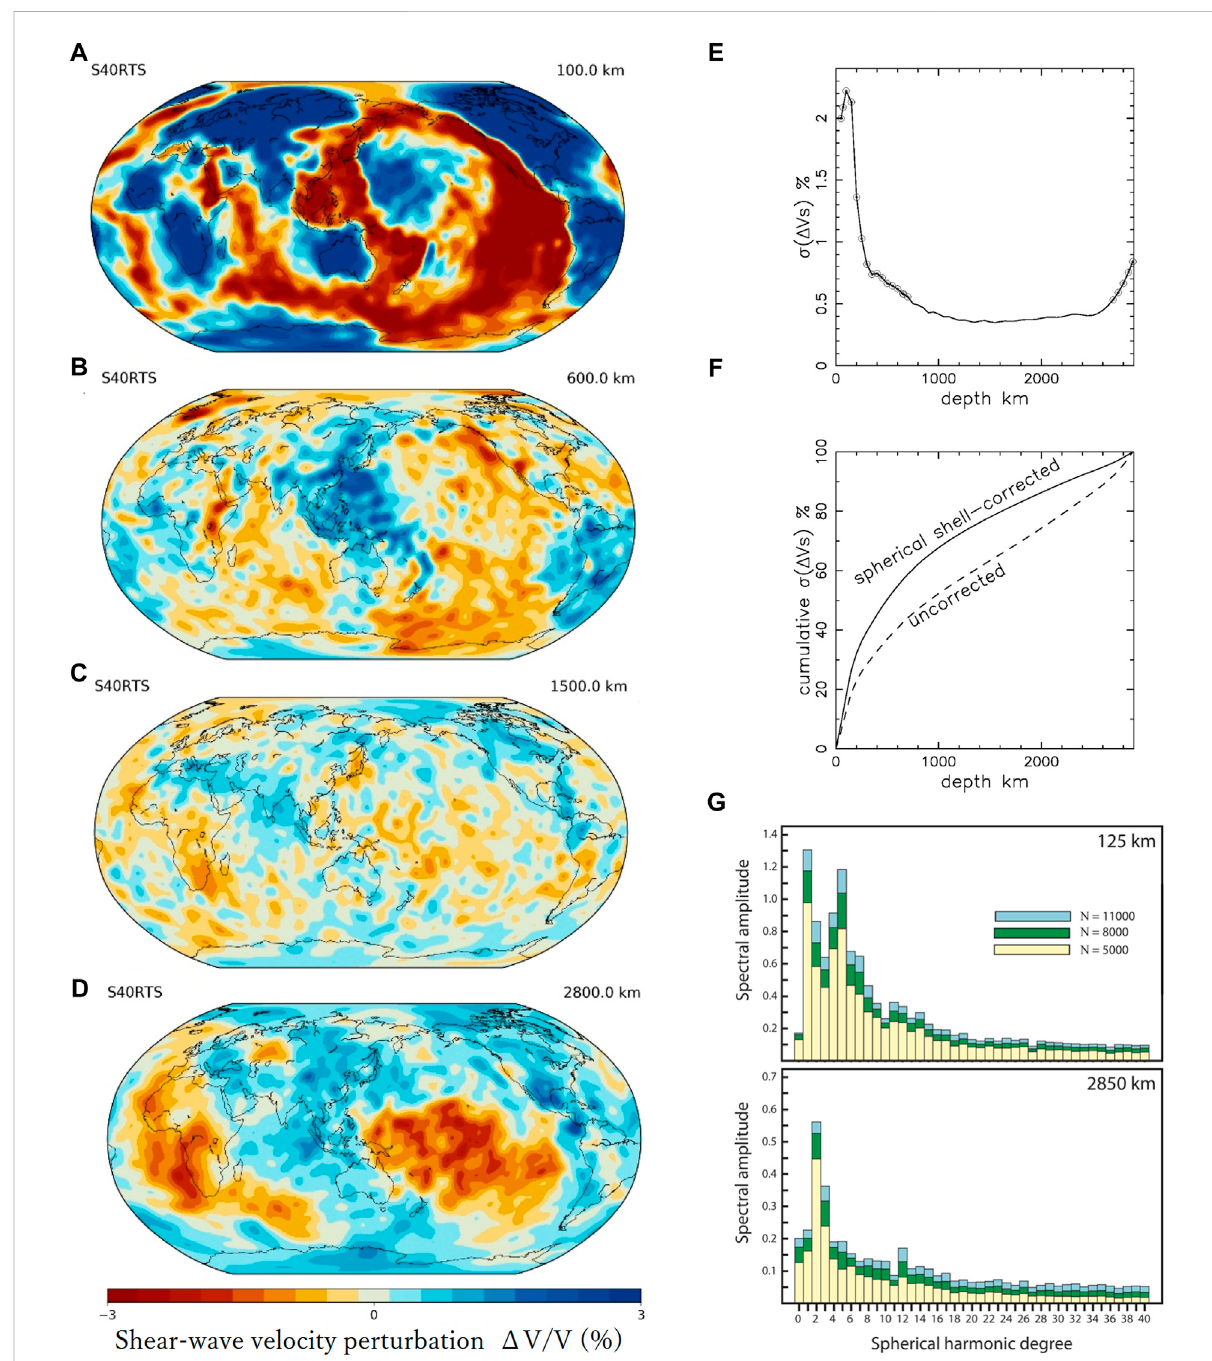
FIGURE 1 SeismicvelocitystructureoftheEarth ’ smantle,after themodelS40RTS(Ritsemaetal.,2011). (A) – (D) Mapsofshear-wavevelocityperturbation ( Δ V / V inpercent)withthesamescalefrom-3to+3%at (A) 100 km, (B) 600km, (C) 1,500 km,and (D) 2,800 kmdepth. (E) depth-pro fi leoftheshear- wavevelocityvariationasexpressedbythestandarddeviationin Δ V / V ,wherecirclesindicatethestandarddeviationgreaterthan0.5%. (F) cumulative standard deviation integrated from the surface to CMB, where the dashed line is simply integrated with depth, and the solid line is multiplied by the spherical area at each depth to re fl ect differences in spherical shell volume. (G) Spectral amplitude at 125 km and 2,850 km depth (after Figure 7 of Ritsema et al., 2011) for the effective number of unknowns N from 5,000 to 11,000. A smaller N indicates a greater